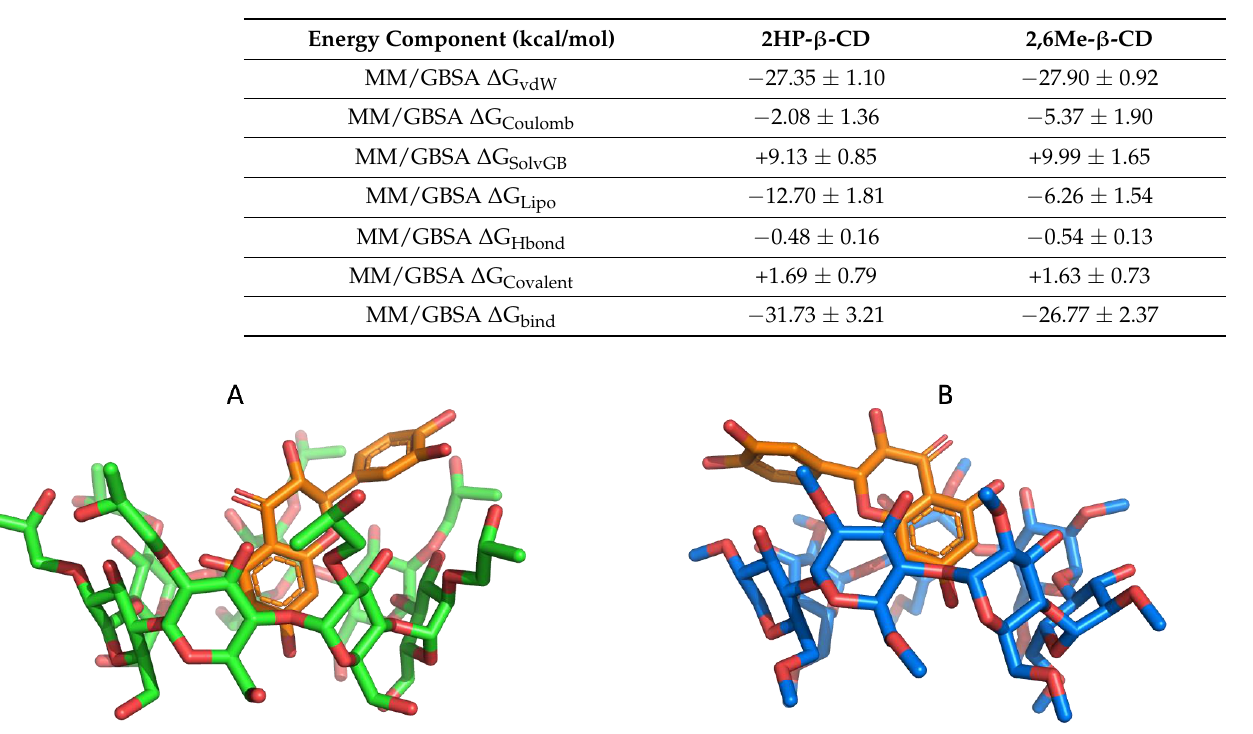
Figure 8. Molecular models of QUE (represented as orange sticks) inside the two cyclodextrin systems calculated as the first cluster representatives from MD simulations. ( A ) 2,6Me- β -CD (green sticks) and ( B ) 2HP- β -CD (blue sticks). Oxygen atoms are represented in red. Table 9. Binding free energy analysis for the QUE/2HP- β -CD and QUE/2,6Me- β -CD complexes as obtained by the MM/GBSA calculations.